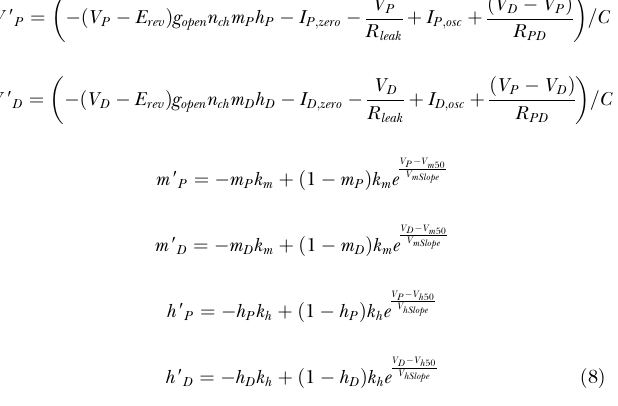
Figure S1. Velocity Dependence (A) Voltage responses evoked by circular-wave stimuli with three different velocities (period: 192 l m; averages of 3 trials; CF motion in orange, CP in blue; V Rest ¼(cid:2) 41 mV). (B) Amplitudes of DC ( V 0 ), fundamental ( V 1 ), and harmonics V 2 and V 3 as a function of stimulus velocity (averages of five cells). Found at doi:10.1371/journal.pbio.0050185.sg001 (487 KB TIF). Figure S2. Holding-Voltage Dependence (Single-Cell Data) Amplitudes of the fundamental ( I 1 ), the second and the third harmonics ( I 2 , and I 3 ) as function of somatic clamp potential ( V COM , as in Figure 5C) of the four cells (A–D) used for the calculation of the asymmetry indices ( AI s) depicted in Figure 5D and three other cells (E–G) that showed only small second harmonics, close to the no- motion level, and were thus not included in the averaged AI s. Found at doi:10.1371/journal.pbio.0050185.sg002 (870 KB TIF). Protocol S1. Estimating the VGCC Slope Conductance and the Number of Ca 2 þ Channels Needed to Generate the Second Harmonic Signals Found at doi:10.1371/journal.pbio.0050185.sd001 (117 KB